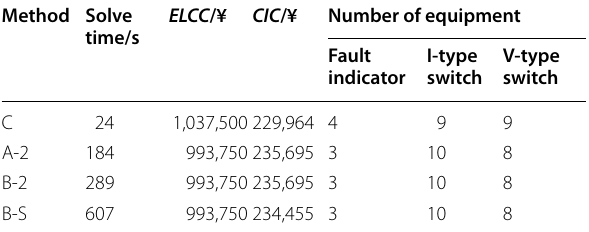
Table 9 Solution results when the failure probability of single equipment is 0.05